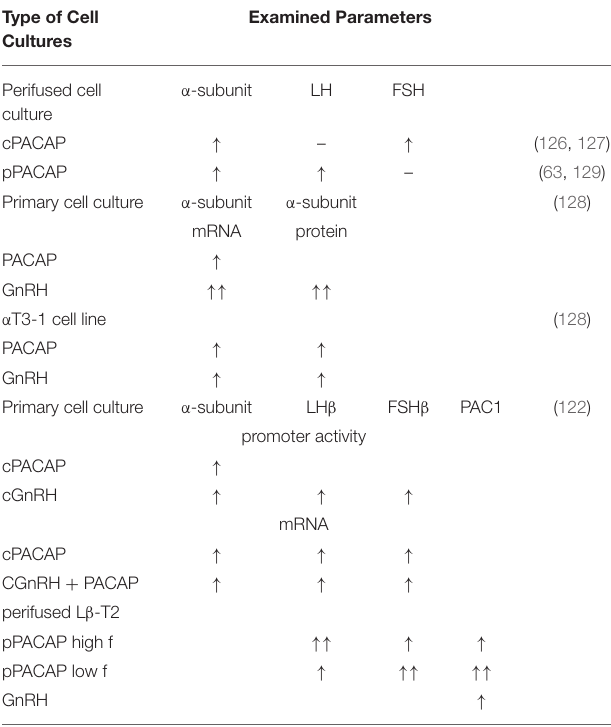
TABLE 2 | Effect of PACAP38 and GnRH on the gonadotropic hormone level and gene expression in cell cultures. Type of Cell